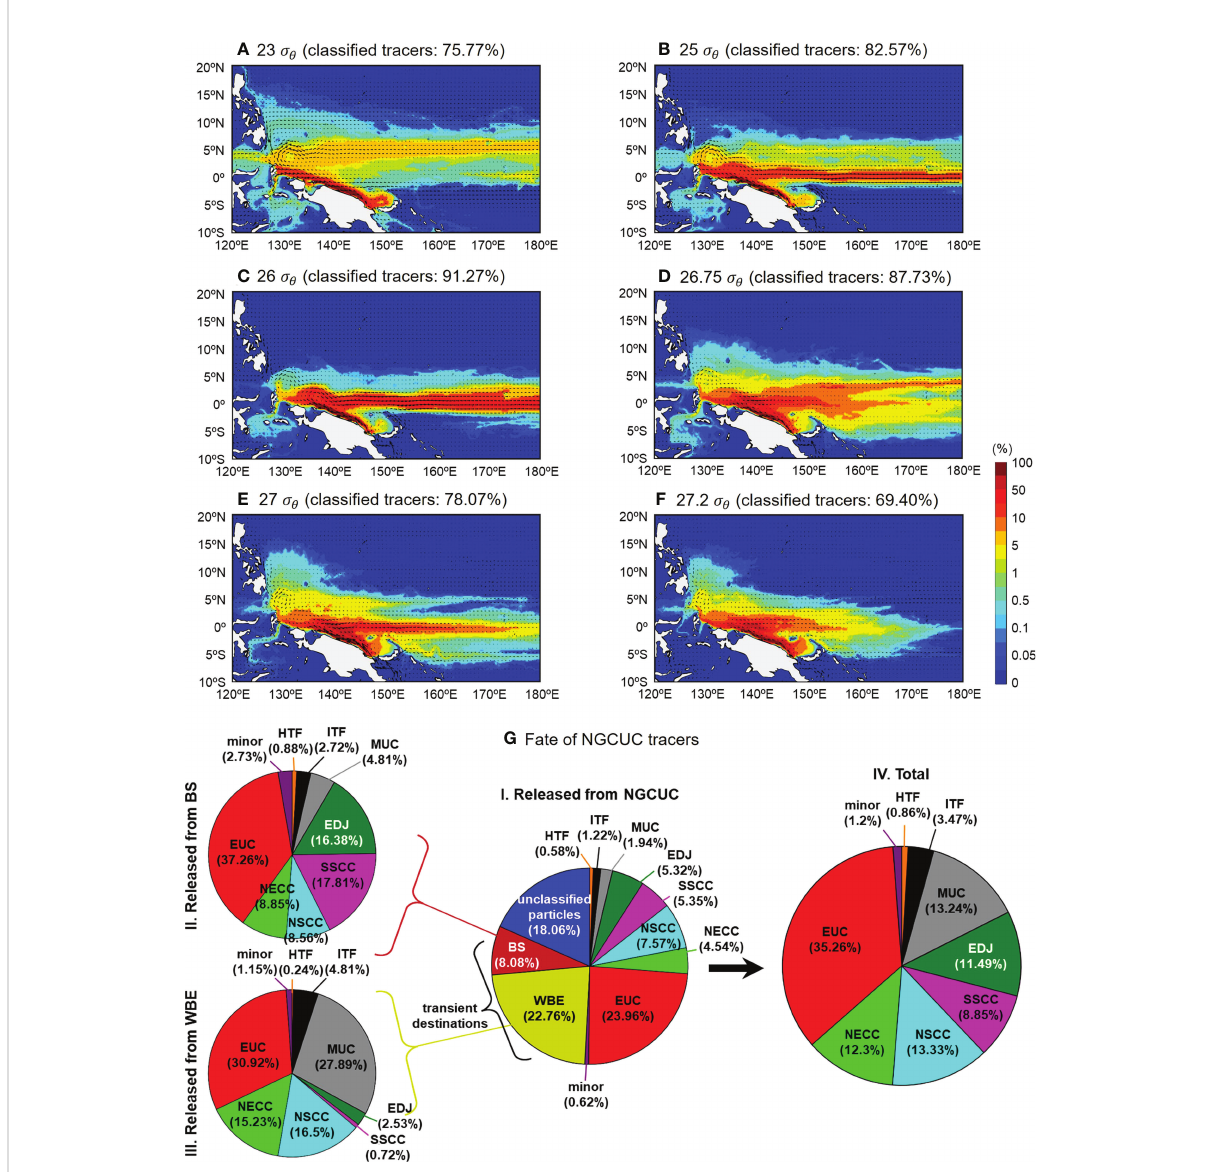
FIGURE 7 Mean probability distribution of tracers (%) released at the NGCUC region (see Figure 2 for the initial position of each tracer) at the isopycnal layers of (A) 23, (B) 25, (C) 26, (D) 26.75, (E) 27, and (F) 27.2 s q . The tracers (50 tracers/layer) were released every day from 1994 to 2013 with the travel time of two years. The black arrows indicate current vectors. (G) Pie charts I, II, and III show the ratio of tracers ’ destinations released directly from the NGCUC, BS, and WBE regions. Pie chart IV shows the ratio of tracers ’ major and minor destinations from the total tracers released from the NGCUC region, including tracers that were temporarily trapped in the BS and WBE